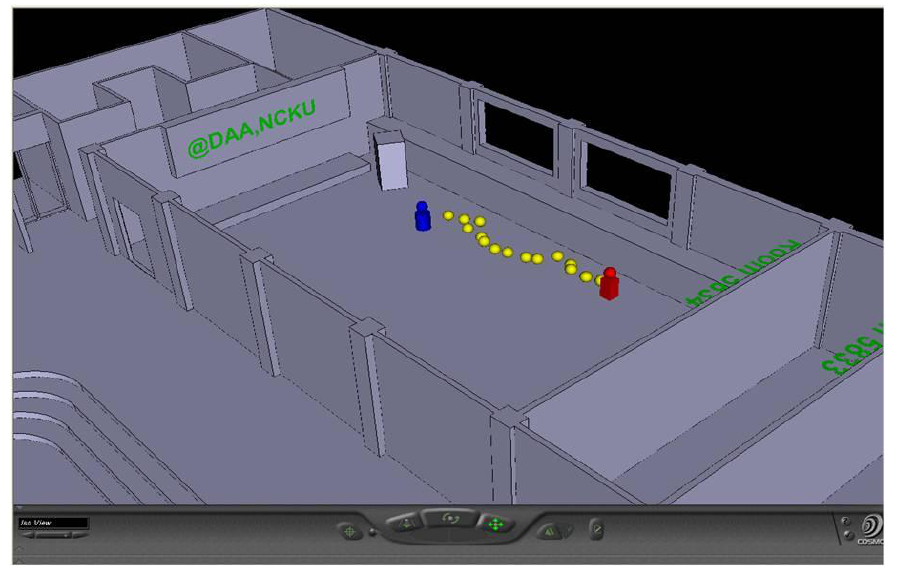
Figure 15. Integration of the indoor positioning results with the 3D